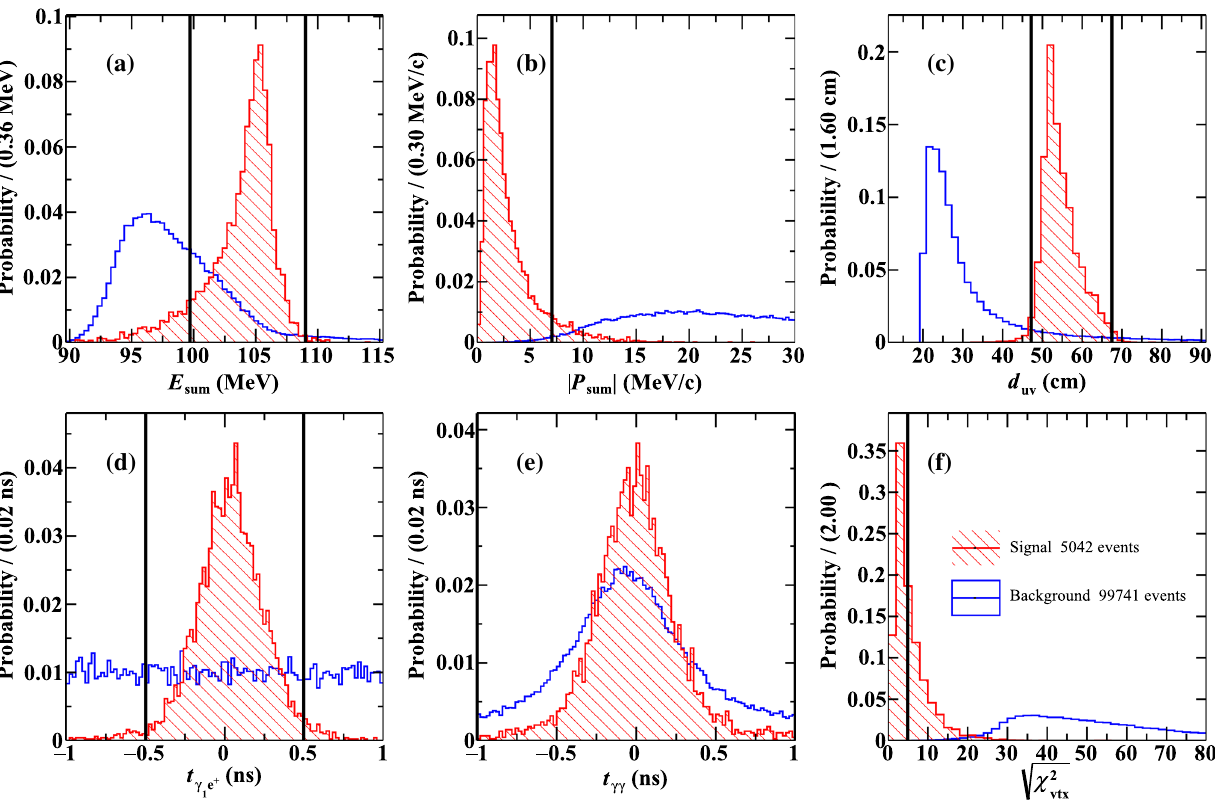
distribution is at m μ with FWHM E = 2.7 MeV. c Cut-off at 20 cm in sum the background distribution comes from one of the 2 γ reconstruction conditions. e The threshold lines are not visible because they are set to ± 1ns. For a detailed definition of the variables see Sect. 6